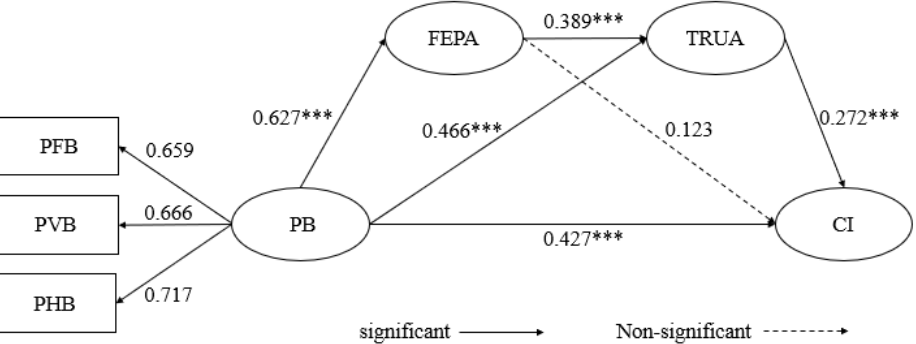
Figure 3. Model parameter estimation results. Note: *** p < 0.001. PFB = Perceived Functional Benefit; PVB = Perceived Value Benefit; PHB = Perceived Health